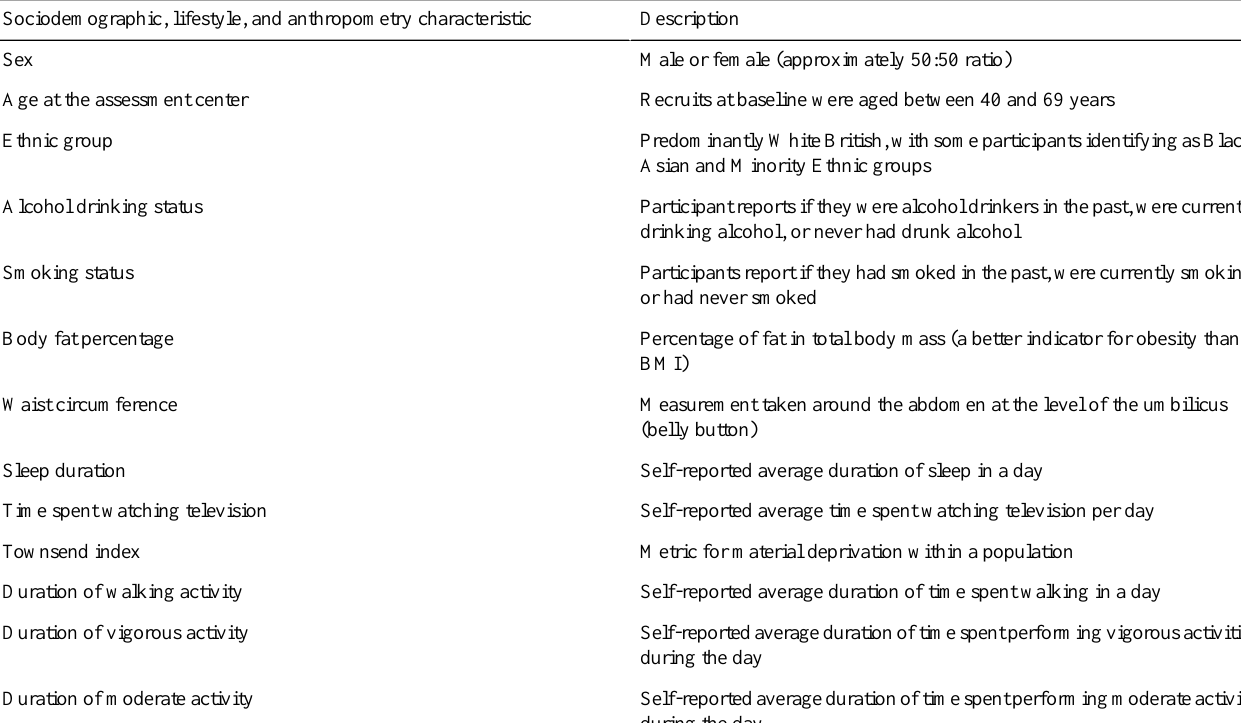
Table 2. Sociodemographic, lifestyle, and anthropometric characteristics selected from the UK Biobank baseline assessment for comparison with high-level activity bout features